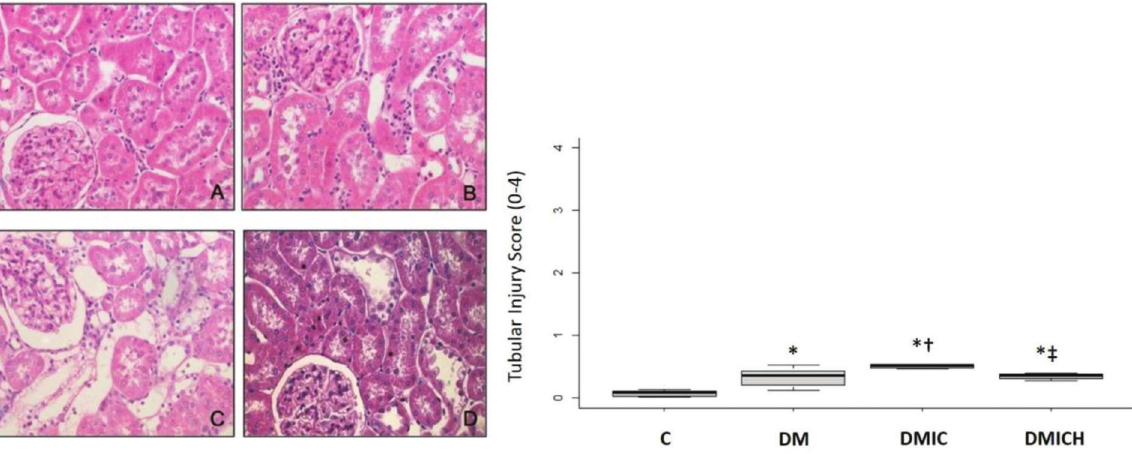
Figure 2 - Mean ( ± SEM) of histological images and tubular injury score from the control and diabetic groups. Representative images of hematoxylin and eosin staining at 400 (cid:1) magnification. n=5–6 per each group. C (A), DM (B), DMIC (C), and DMICH (D). * p o 0.05 versus C, w p o 0.05 versus DM, = p o 0.05 versus